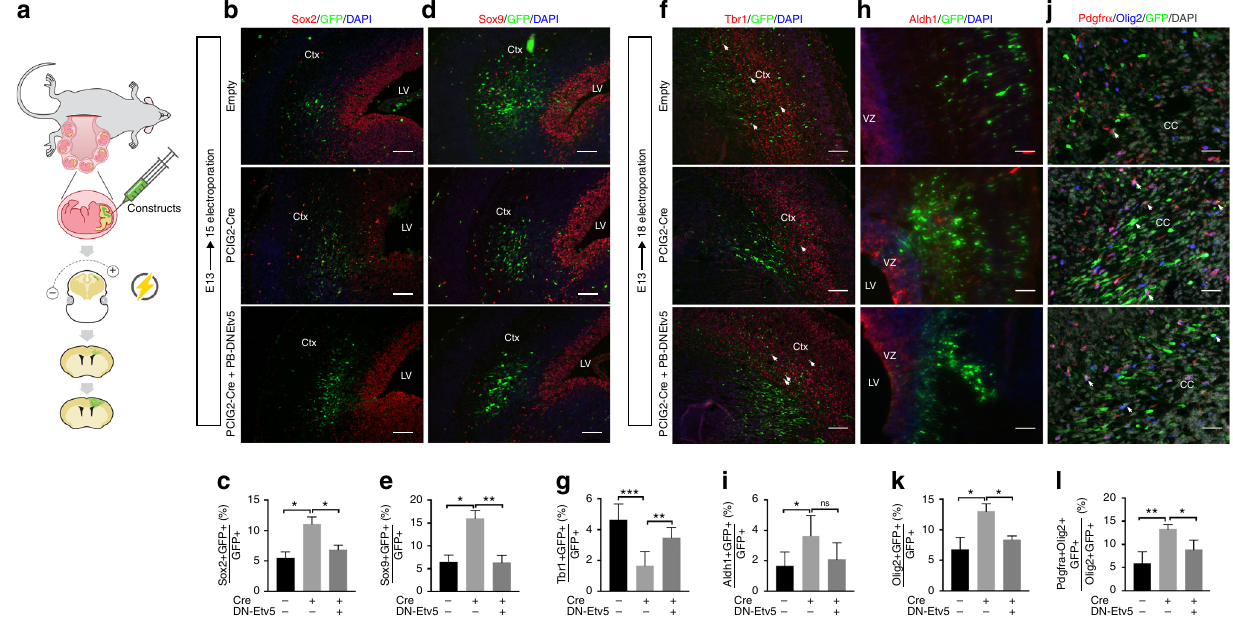
Fig. 4 Deletion of Cic in the neurogenic period biases NSCs to glial lineage selection. a Localized deletion of Cic in neural stem cells via in utero electroporation into VZ cell of C ic- fl oxed embryos; targeted cells carry a fl uorescent marker and express either cre recombinase (Cre), dominant negative ETV5 (DNETV5), or not (Empty control), depending on the electroporated plasmid. b – l Immuno fl uorescence staining and quantitation of cells in the electroporated patch. Sox2 + stem cells b , c and Sox9 + glioblasts d , e in n = 4 per group 2 days after E13 electroporation, analyzed at E15. Late-born Tbr1 + neurons f , g , Aldh1 + astrocytes h , i , Olig2 + oligodendrogial lineage cells j , k , and Pdgfra + oligodendrocyte precursors cells l detected 5 days after E13 electroporation, analysis at E18. Data from n = 5 for control and n = 6 mice for Cre for Tbr2 staining; n = 6 for control and n = 5 for cre for Aldh1 staining; and n = 4 per group for Olig2 and Pdgfra staining. Statistical analyses between control and experimental groups performed by ANOVA with Tukey ’ s post hoc test. Scale bars: 50 μ m. Source data are provided as a Source Data fi le. Data shown as mean ± SD. * p < 0.05, ** p < 0.01, *** p < 0.001, ns – not signi fi cant. Labels: Ctx – cortex, LV – lateral ventricle, VZ – ventricular